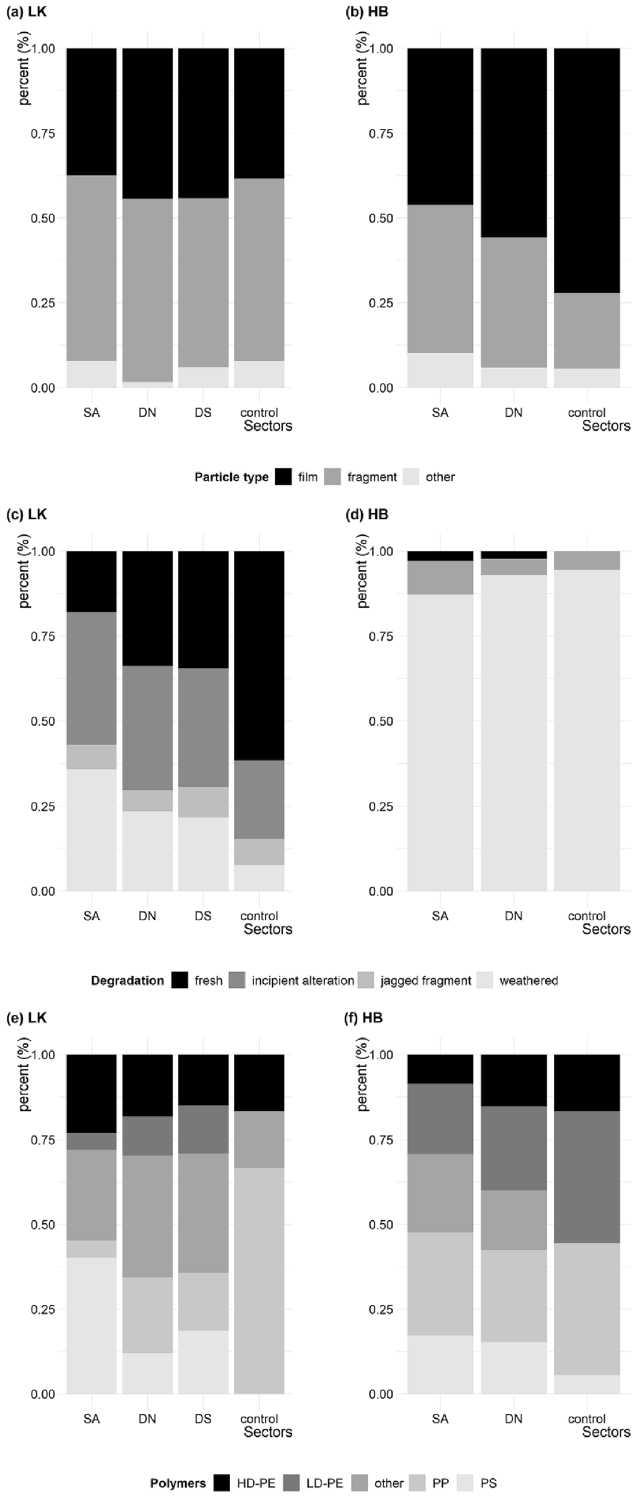
Figure 3. Characteristics of plastic items from soil surfaces in comparison between sector groups: (SA) sludge application sectors, (DN) direct neighbour sectors and (DS) distant sectors including control sectors. Item form composition on field ( a ) “Lehmkaute” and ( b ) “Holzbach”, item surface degradation composition on field ( c ) “Lehmkaute” and ( d ) “Holzbach”, item identity composition on field ( e ) “Lehmkaute” and ( f )